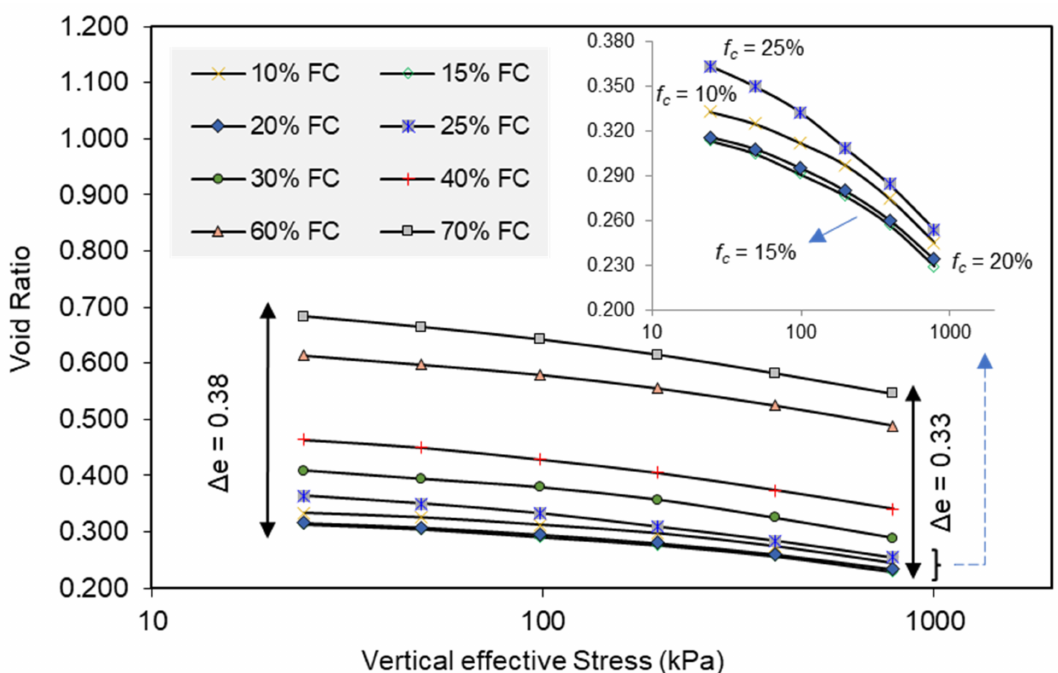
Figure 6. Variation of void ratio with vertical effective stress for each fines content.